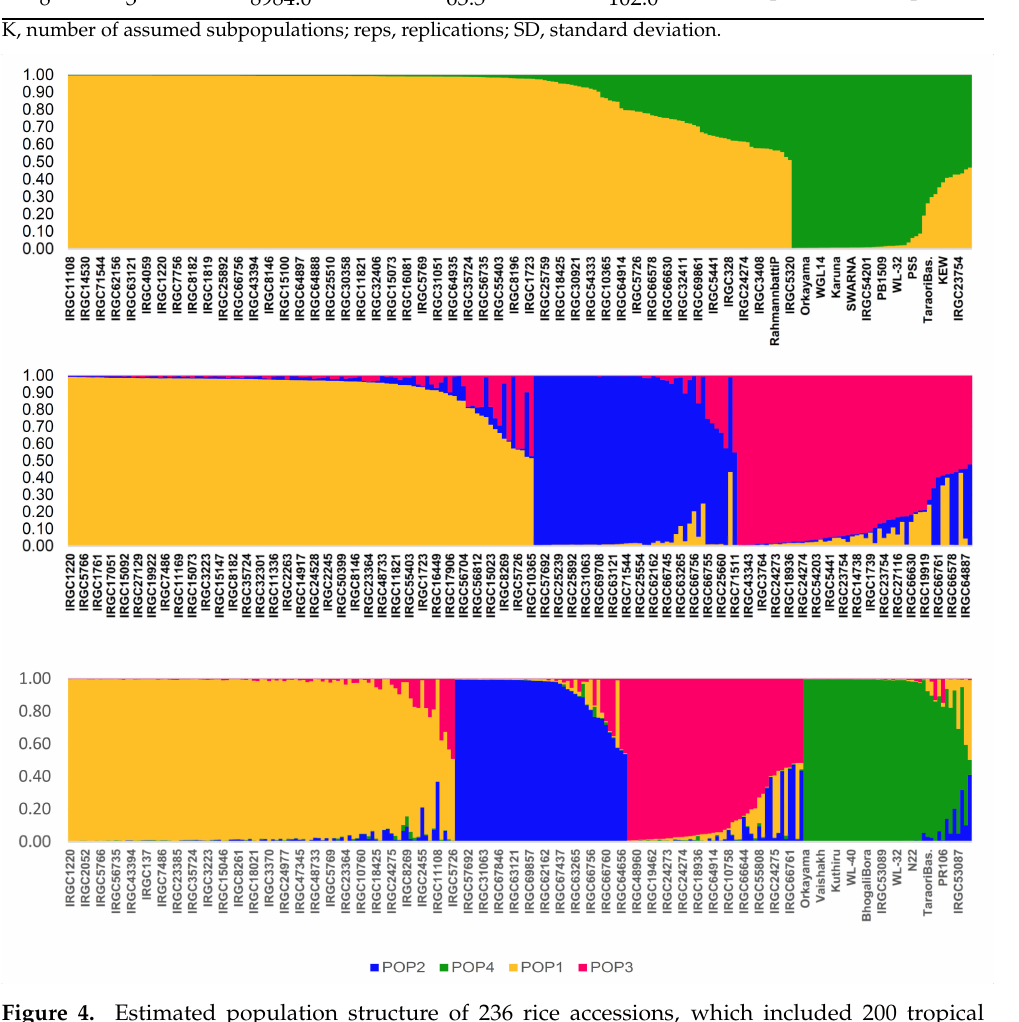
Figure 4. Estimated population structure of 236 rice accessions, which included 200 tropical japonica